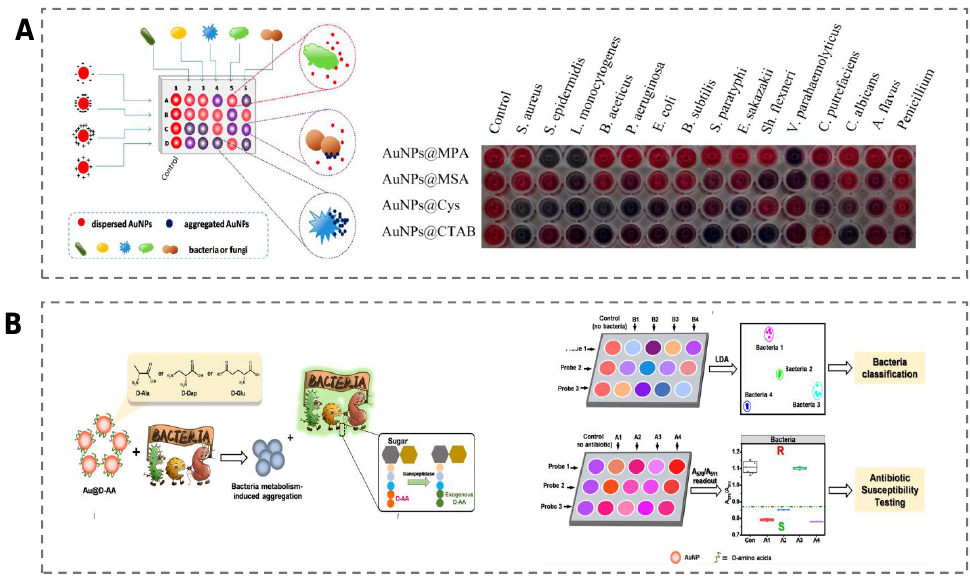
Figure 7. Supervised algorithm-based colorimetric sensor array for pathogen identification. ( A ) A colorimetric sensor array with diverse surface charges of AuNPs for microorganism identification by LDA algorithm. Reproduced with permission [117]. Copyright 2017, American Chemical